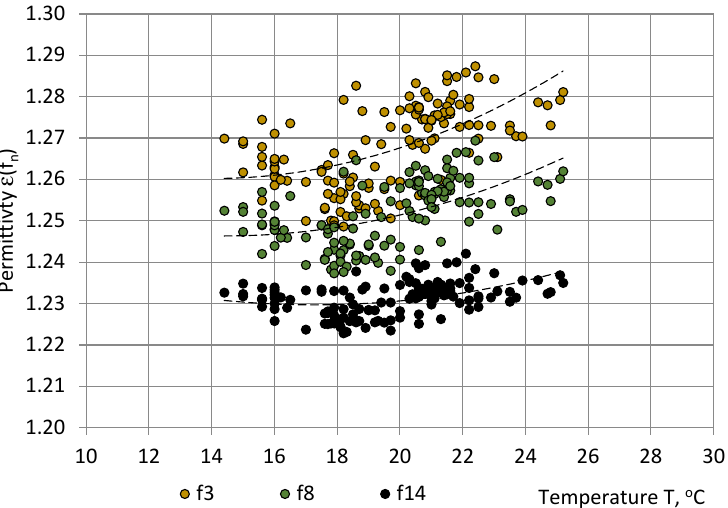
Figure 6. Correlation between the permittivity ε of PU SikaBlock ® -M150 foams (density of 144 kg/m 3 ) and the atmospheric temperature T in the test room at frequencies f 3 = 40 Hz (beige), f 8 = 1280 Hz (green), and f 14 = 81,920 Hz (black).